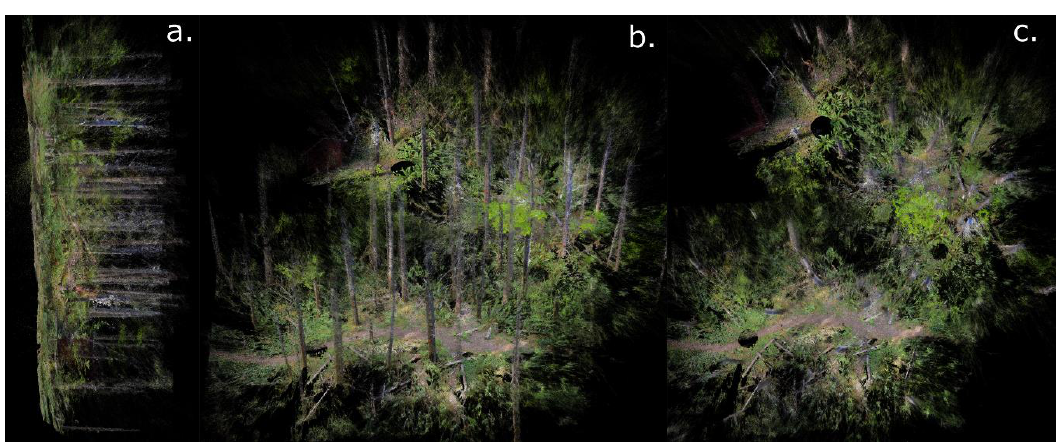
Figure 5. Correction to nadir view of the photogrammetric point clouds (PPC) produced with structure-from-motion at three locations ( a ) initial rendered position (almost perspective view); ( b ) oblique view; ( c ) nadir view.